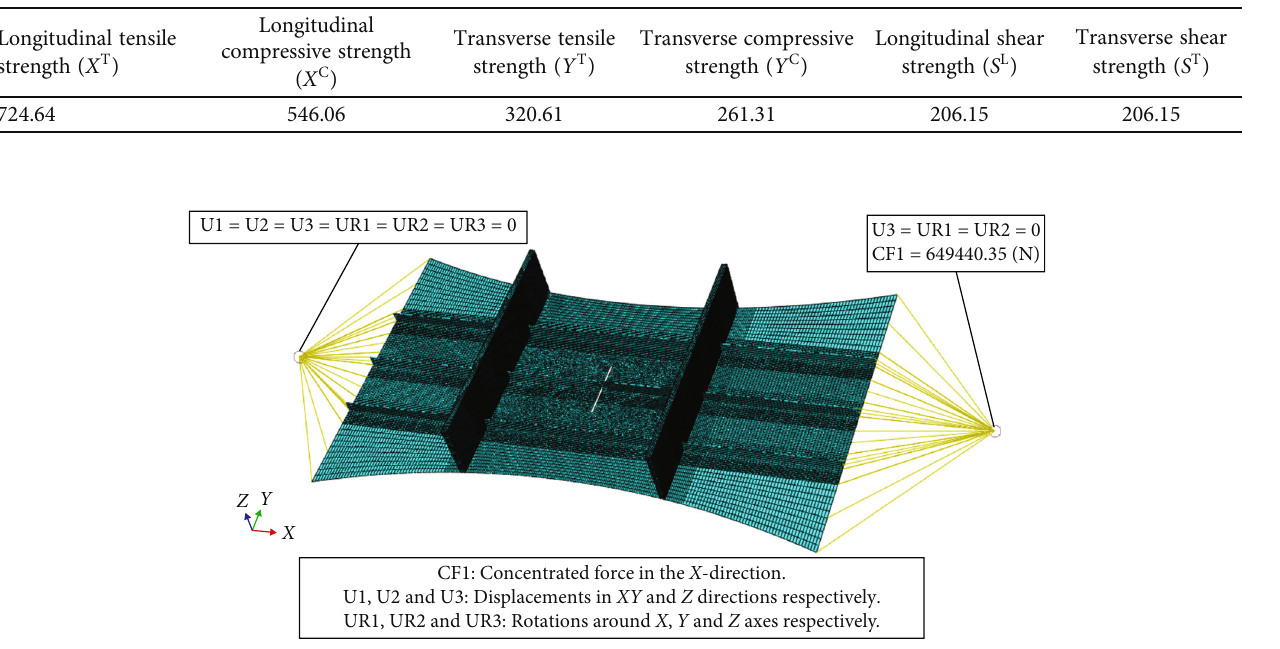
Figure 4: Damaged panel ’ s boundary